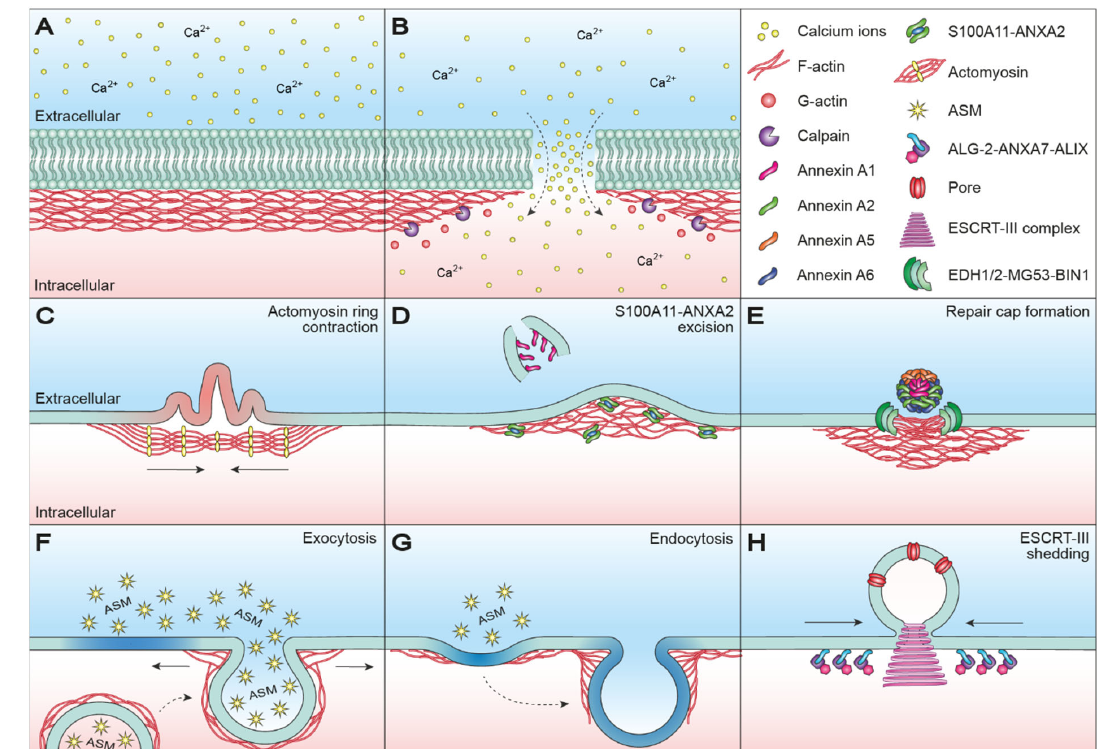
Figure 1. Actin-associated plasma membrane repair mechanisms in single-cell wound repair. ( A ) The PM and underlying cortical actin cytoskeletal are intact and maintaining cellular homeostasis. ( B ) Disruption of the PM causes a rapid influx of Ca 2+ , which causes depolymerization of actin filaments to G-actin monomers primarily through Ca 2+ -dependent activation of intracellular calpain proteases. Moreover, the increase in intracellular Ca 2+ activates and recruits repair machinery for membrane resealing. ( C ) Subsequent to membrane patching, PM restoration in Xenopus oocytes occurs by contraction of an actomyosin ring anchored to the uninjured membrane at regular intervals. Ring contraction pushes injured membrane (red) outward, while dragging uninjured membrane (green) inward. ( D ) S100A11-ANXA2-dependent actin polymerization promotes wound closure by pulling the membrane edges towards each other for resealing and excision of injured membrane marked by ANXA1. ( E ) In muscle cells, formation of an annexin-rich repair cap, consisting of ANXA1, ANXA2, ANXA5 and ANXA6, and an underlying clearance zone of F-actin are required for efficient sarcolemma repair. An adjacent shoulder of repair proteins, EDH1/2, MG53 and BIN1, further aids the repair process. ( F ) Injury-induced lysosome-exocytosis reduces in-plane tension and generates ceramide microdomains (blue) through secretion of ASM. Mesoscopic modulation of the actin cytoskeleton is a prerequisite for vesicular exocytosis, since cortical actin comprises a mechanical barrier preventing vesicle fusion. At the same time, vesicle fusion cannot occur without some degree of actomyosin-mediated assistance. ( G ) ASM-generated ceramide microdomains (blue) trigger membrane invaginations, thereby priming the membrane for endocytosis-mediated restructuring. Because several steps of the endocytic process require delicate actin modulation, the internalization of injured membrane regions is highly dependent on actin dynamics. ( H ) ESCRT-III-mediated shedding of pore-injured membrane regions through spiral contraction. Ca 2+ -dependent formation of ALG-2-ANXA7-ALIX complexes at the injury site promotes the sequential recruitment of ESCRT-III components, resulting in complex assembly and microparticle shedding. ANXA: annexin; ALG-2: apoptosis-linked gene-2; ALIX: ALG-2-interacting protein X; ASM: acid sphingomyelinase; BIN1: Myc box-dependent-interacting protein 1; Ca 2+ : calcium ions; EDH1/2: EH-domain-containing protein 1/2; ESCRT-III: endosomal sorting complex required for transport III; G-actin: globular actin; MG53: Mitsugumin